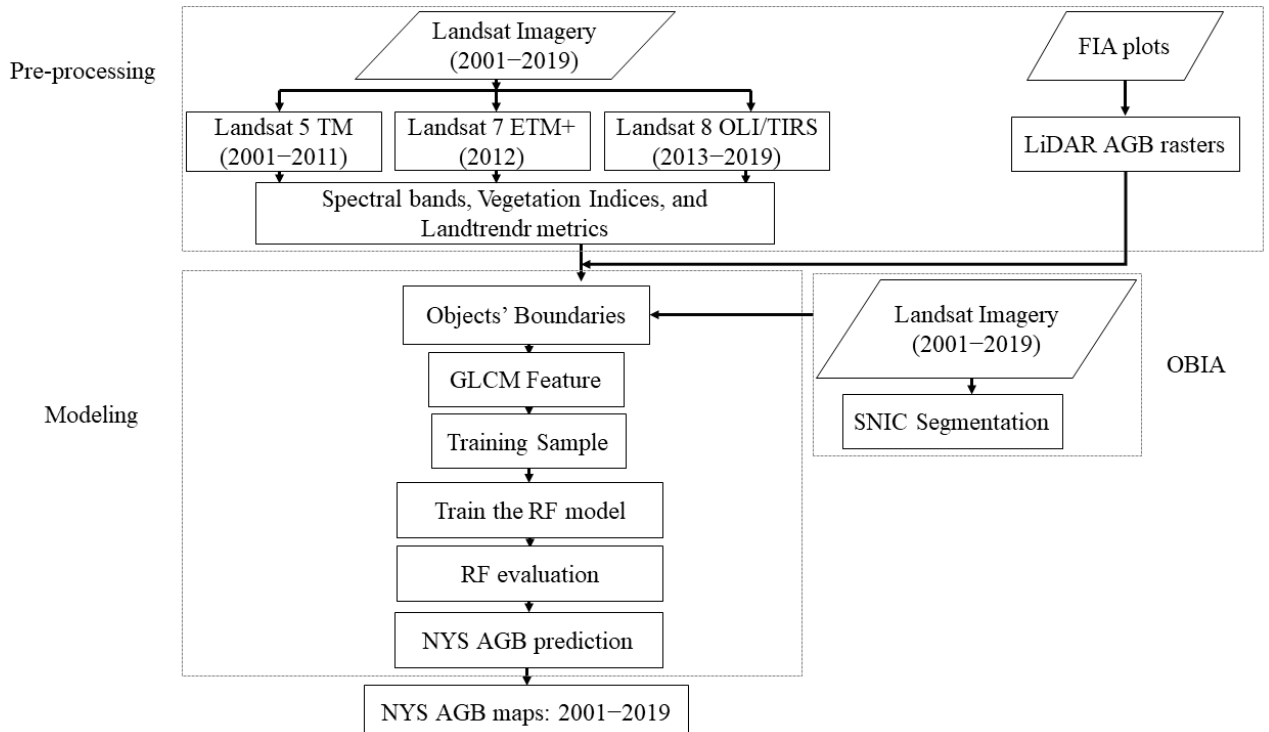
model and Landsat Figure 2. The proposed object-based AGB estimation workflow using random forest regression model and Landsat imagery.